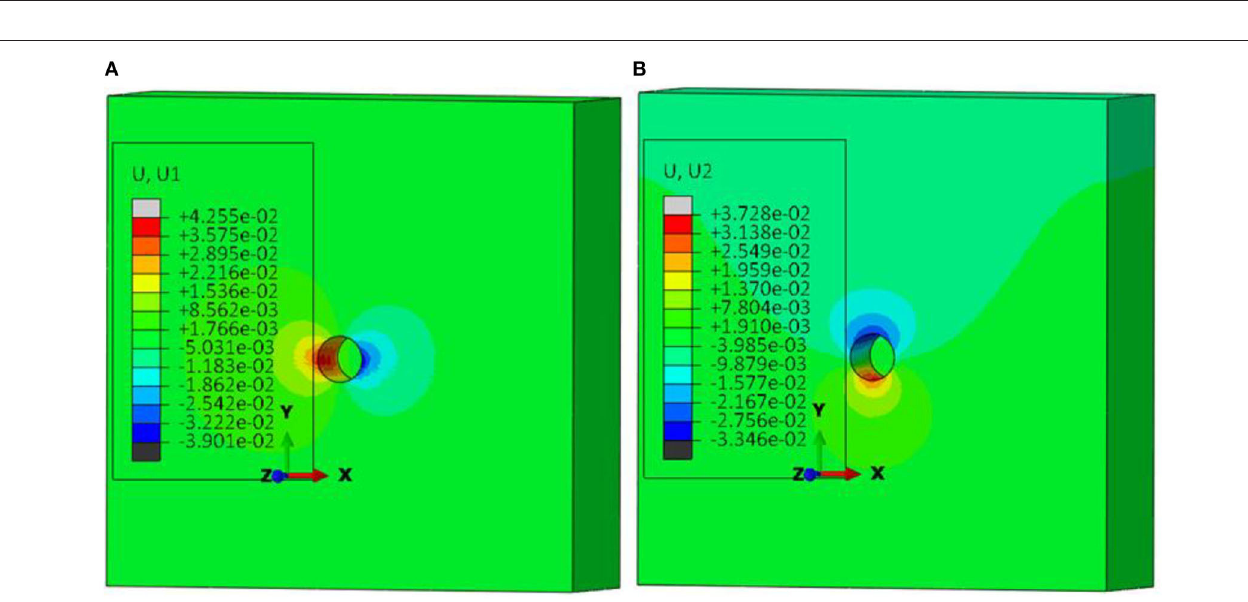
FIGURE 9 | Displacement nebulogram after excavation and support: (A) Horizontal displacement after stabilization (B) Vertical displacement after stabilization (Unit: m).